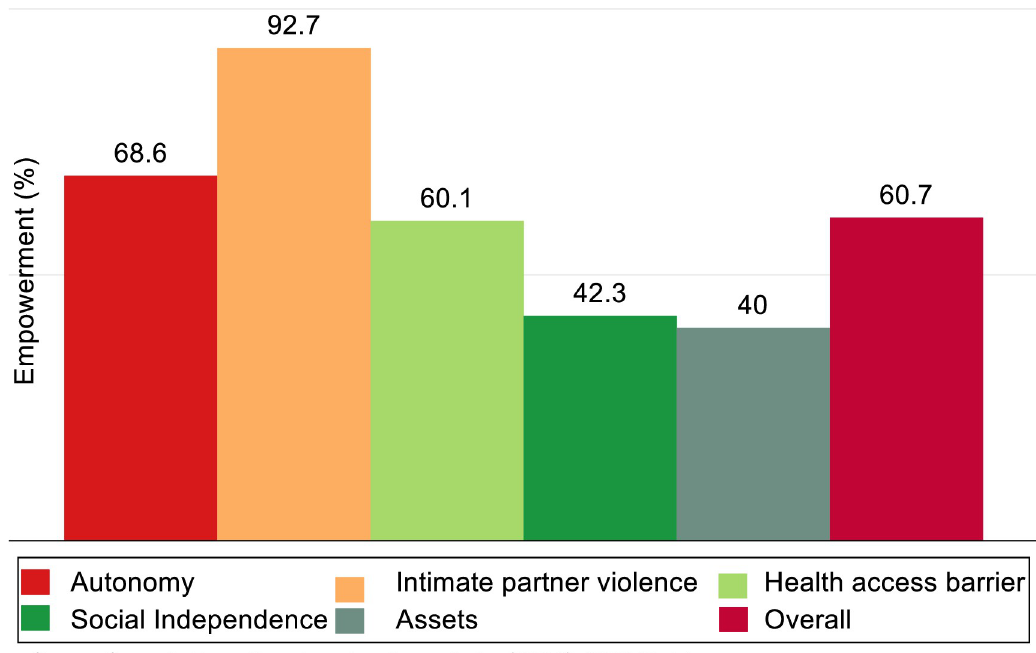
Fig 3. Percentage of average empowerment in the dimensions along with overall empowerment among Bangladeshi women.